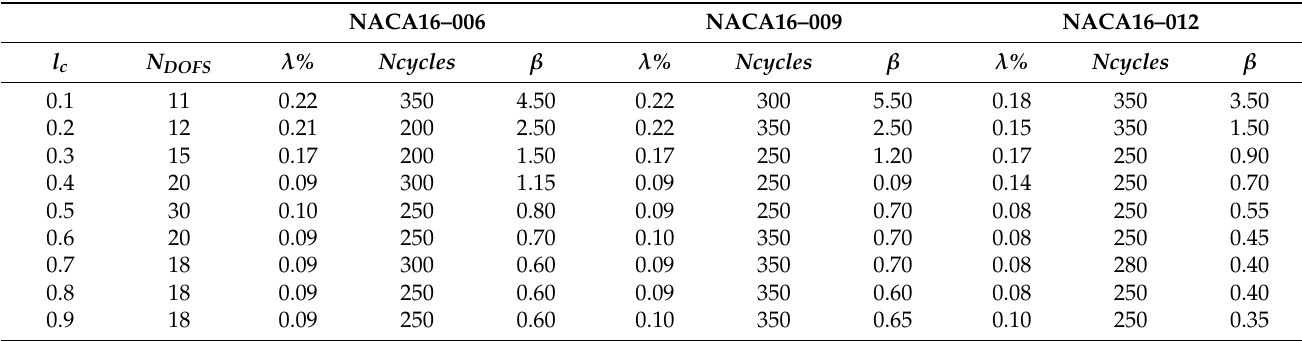
Figure 9. Comparison between the present method (PM) and numerical results found in Uhlman [22] for the NACA 16–006, 16–009, 16–012 sections at a = 4 ◦ . The sectional area is presented as a function of cavity length. Table 2. Simulation parameters for the PCavPreMod